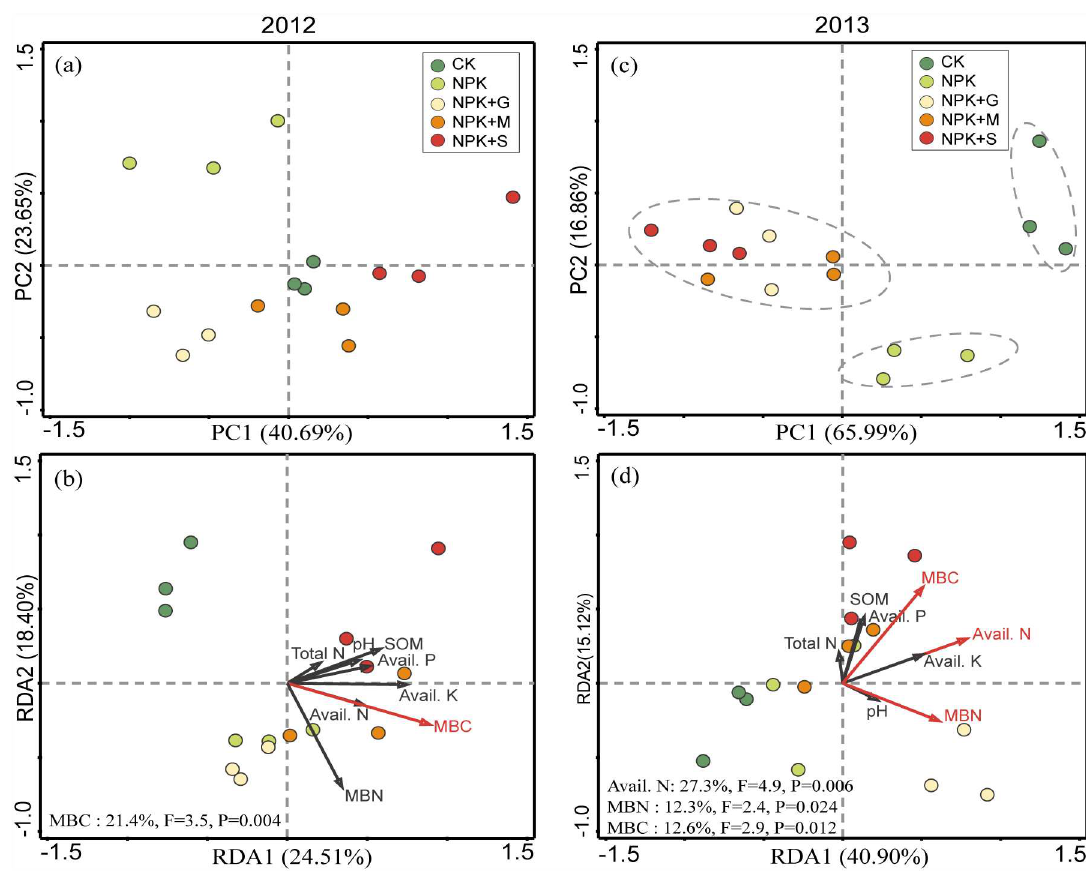
Fig 6. Principal Component Analysis (PCA) of microbial community composition (relative content of individual PLFA molecules) in soils under different fertilizations in the late rice season of 2012 (a) and the early rice season of 2013 (c), and Redundancy Analysis (RDA) of the correlations between soil parameters (chemical properties and microbial biomass C/N) and microbial community composition in the late rice season of 2012(b) and the early rice season of 2013 (d). The red arrows indicate the soil parameters that had a strong and significantimpact on the microbialcommunity composition( P < 0.05), and the corresponding explainedproportionof variabilityis shown in the lower left corner.